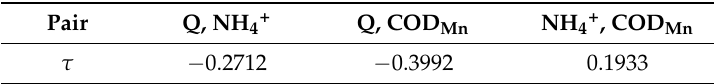
Table 3. The correlation coefficient τ of Q, NH 4+ , and COD